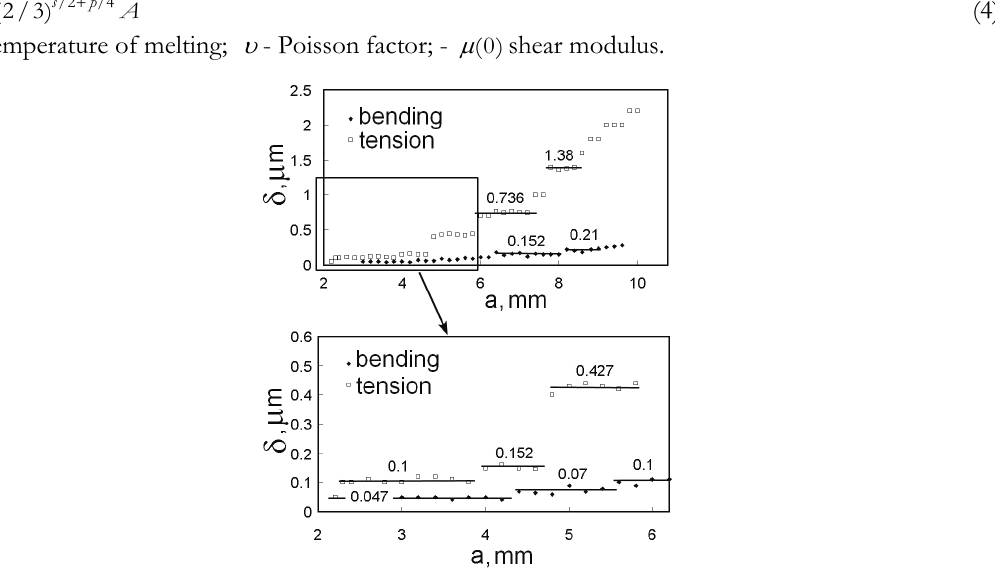
Figure 3: Fatigue striation spacing against crack growth in the depth direction for semi-elliptic crack in a specimen of AK6 Al-based alloy. Numbers indicate spacing-values calculated in accordance with Eq.2.